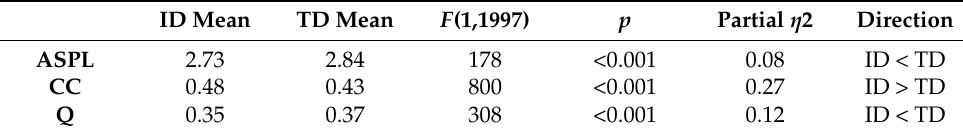
Table 1. The result from the pooled bootstrap analyses for ASPL, CC, and